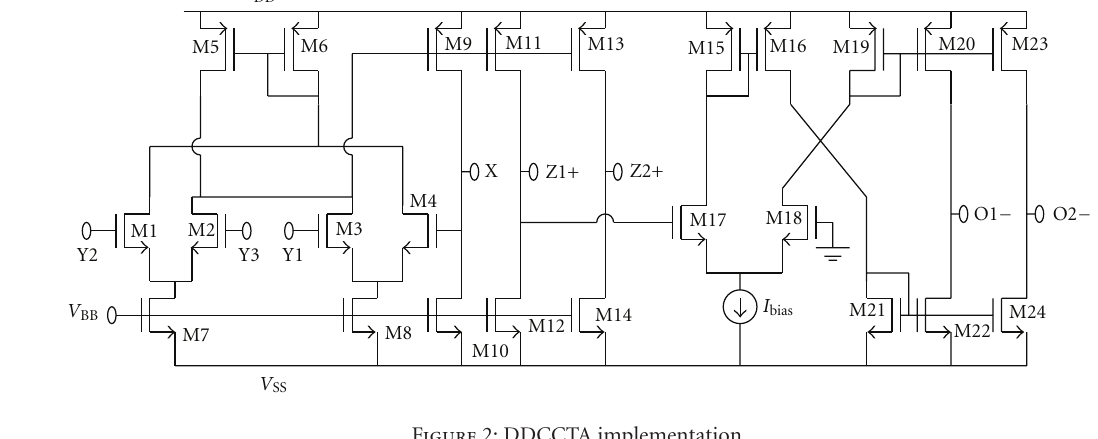
Figure 2: DDCCTA